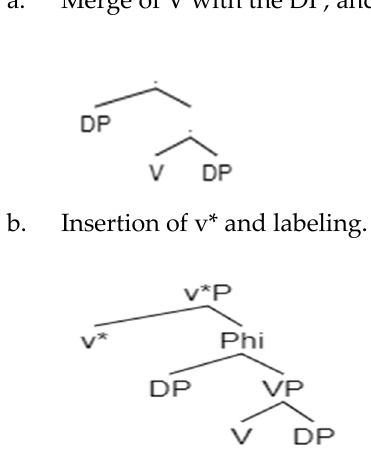
a. Merge of V with the DP, and movement of the DP.